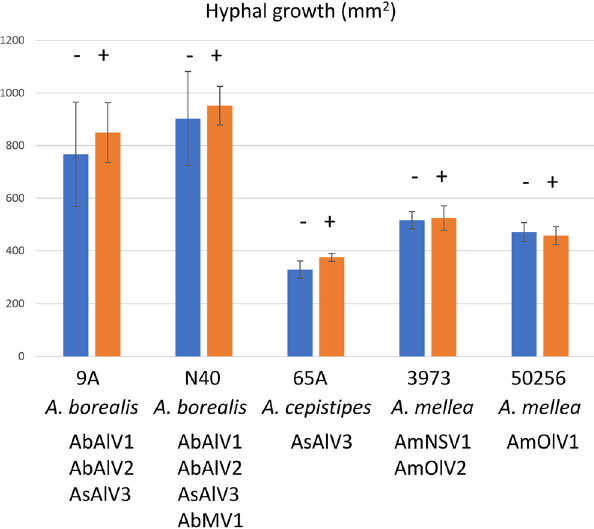
Figure 7. Growth of isogenic virus-infected and virus-free isolates of Armillaria in three weeks at 20 °C on 2% MEA agar plates. Blue (−) = thermal treated (virus-free); orange ( +) = virus-infected. The error bars indicate standard deviation. The t-test p-values ranged from 0.405 to 0.738 except for 65A that showed a p-value of 0.015 when comparing the isogenic strains (the growth of the virus-infected strain was on average 14% higher than that of the virus-free isogenic strain in three weeks). The number of replicate plates measured was 6 (4 for virus- free isolate N40 due to desiccation of two